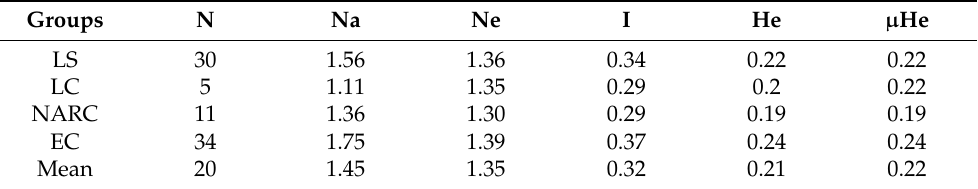
Table 4. The summary of statistical analysis of genetic diversity across 80 potato genotypes based on 11 iPBS primers.